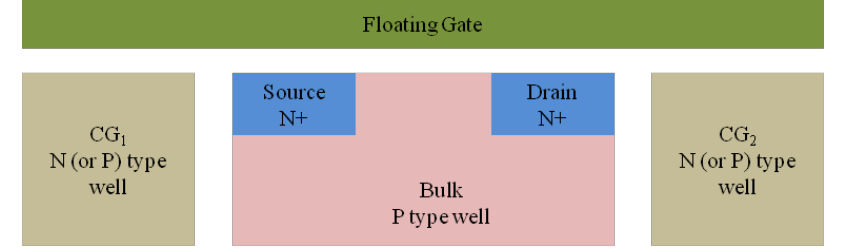
Figure 2. Cross section of the proposed active noise control (ANC) device based on an evolution of a single-poly metal–oxide–semiconductor field-effect transistor (MOSFET), including a source region (S), a drain region (D), a bulk region (B), a floating gate (FG), and two control gates ( CG 1 and CG 2 ).